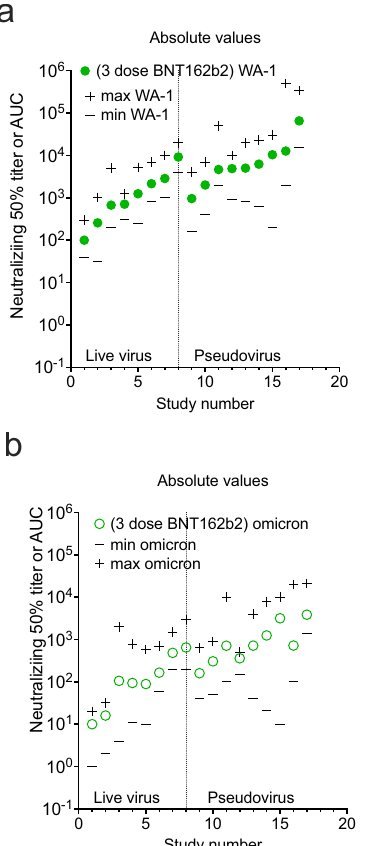
Fig.7|GMT 50 fromeachstudywithminimumandmaximumdilutiontiteralso shown.a 3-doseBNT162b2againstWA-1, b 3-doseBNT162b2againstOmicronBA.1. Source data are provided as a Source Data fi